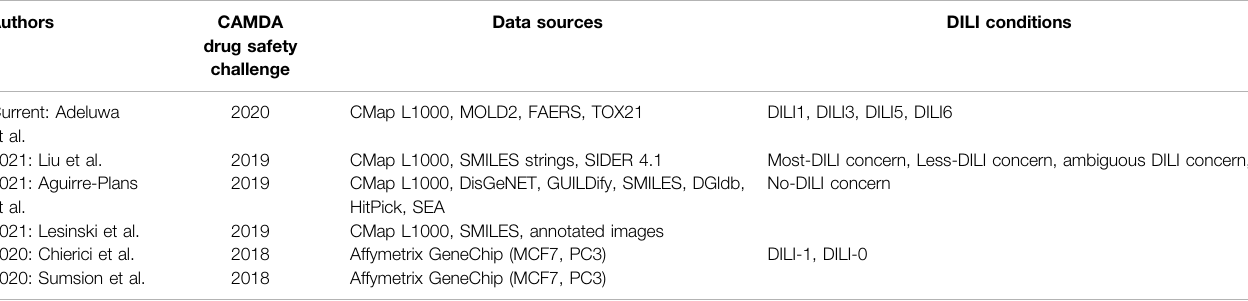
TABLE1| PreviousCAMDADrugSafetyChallengeSummary.TheCMapDrugSafetyChallengehasbeenarepeatedeffortbyCAMDAtodeveloppredictivemodelsforDILI. Previous studies are cited by their year of publication and leading author while also describingthe year in which the challenge wasadministered by CAMDA and relevant data sources and DILI classi fi cations for